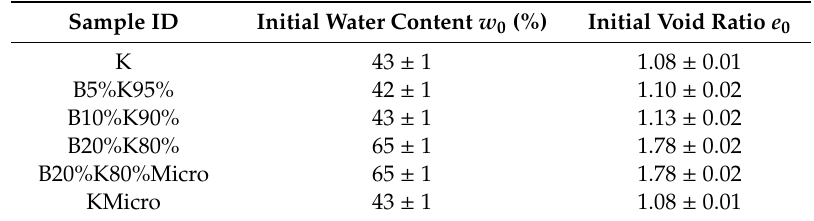
Figure 2. Sketch of the equipment for the oedometer test. Table 1. Initial state of the